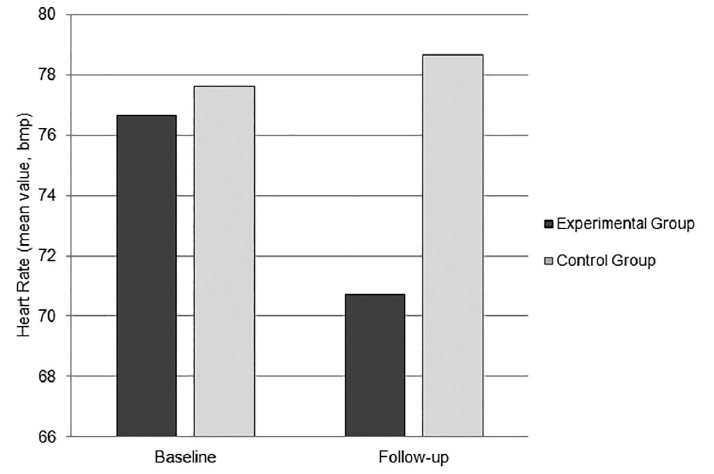
Figure 2. Between-group differences in heart rate data.